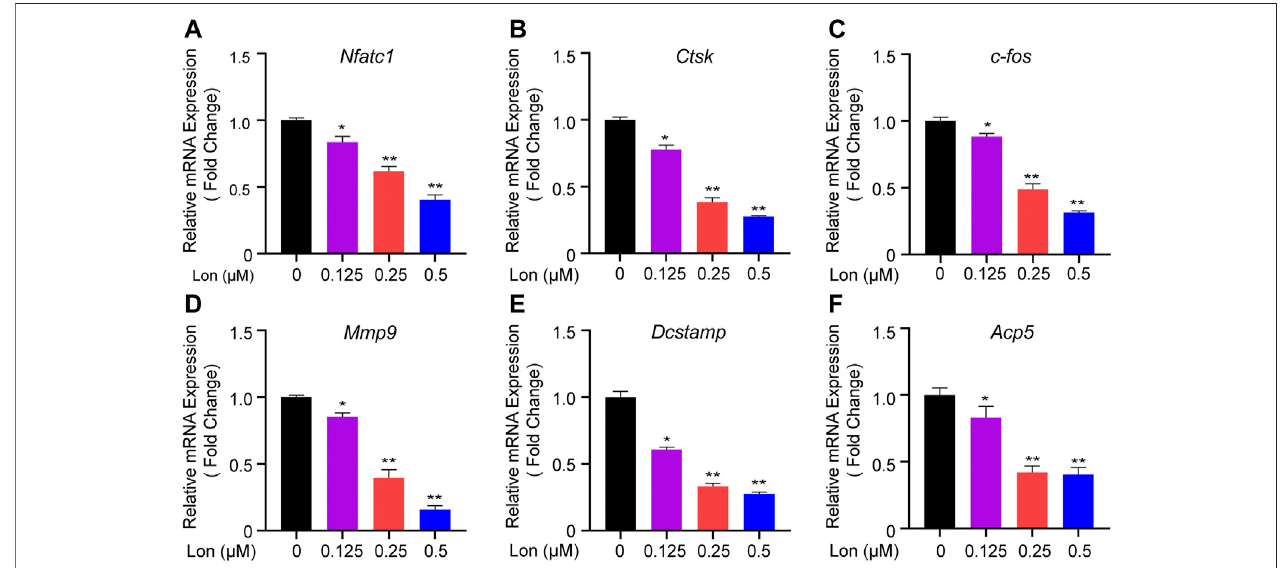
FIGURE 5 | Lon attenuates relevant osteoclastic gene expression. (A – F) QT-PCR analysis of the expression levels of the relevant osteoclast genes Nfatc1 , Ctsk , c-fos , Mmp9 , Dcstamp ,and Acp5 relativeto β -actin inBMMsstimulatedwithRANKLfor5daysinthepresenceofLon.Alloftheabovedataareexpressedasthemean± SD, n = 3 per group. * p < 0.05, ** p < 0.01 compared with control group (without Lon treatment). Acp5 , acid phosphatase 5, tartrate resistant; c-fos , Proto-oncogene C-Fos; Ctsk , Cathepsin K; Dcstamp , dendritic cell-speci fi c transmembrane protein; Lon, Lonafarnib; Mmp9 , matrix metalloproteinase-9; Nfatc1 , nuclear factor of activated T cells 1; RANKL, receptor activator of nuclear factor- κ B